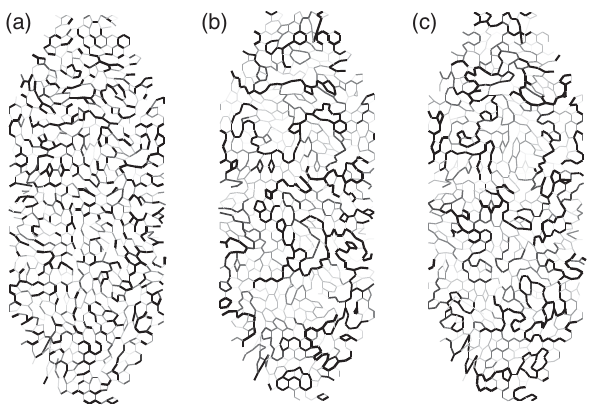
FIG. 8. Examples of different edge-weight assignment func- tions on a two-holed torus. (a) Random. (b) Lines, no self- avoidance. (c) Lines with SA. Note the high similarity between (b) and